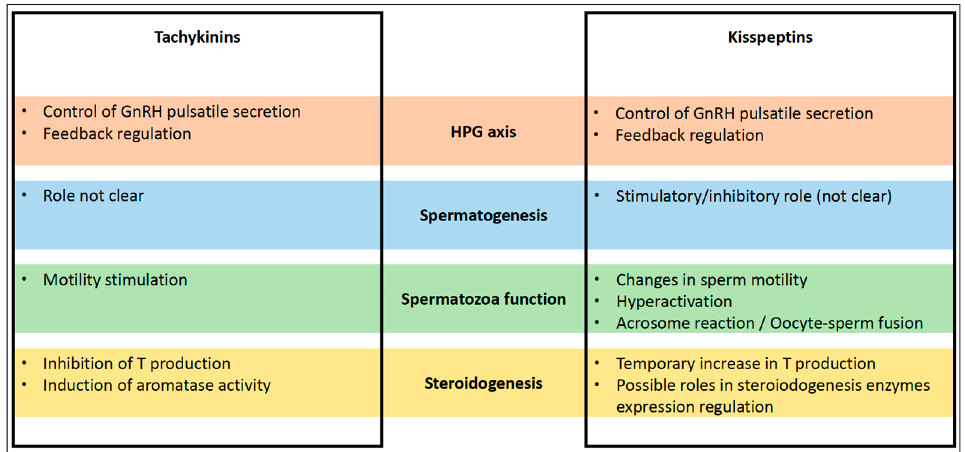
Figure2. Rolesoftachykininsandkisspeptinsinmalefertilityregulation. HPG,hypothalamic–pituitary– Figure 2. Roles of tachykinins and kisspeptins in male fertility regulation. HPG, hypothalamic– gonadal; T, testosterone. GnRH, gonadotropin releasing pituitary–gonadal; T, testosterone. GnRH, gonadotropin releasing hormone.